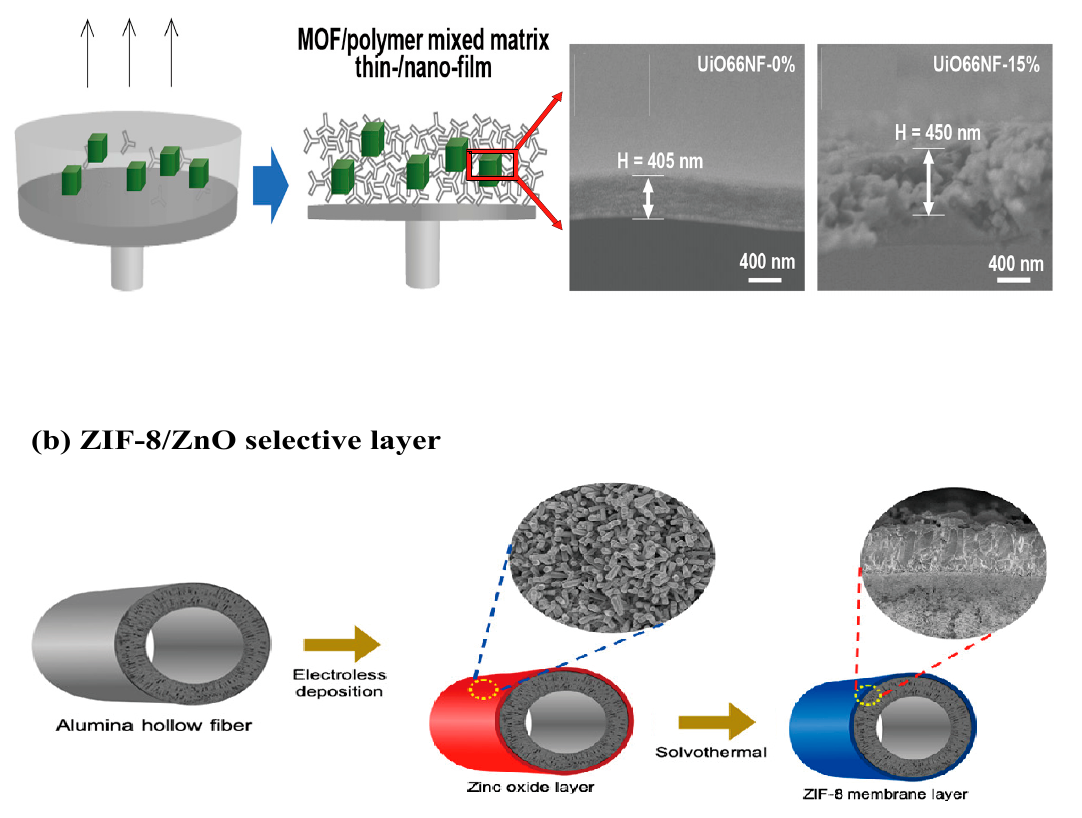
Figure 10. Review of the novel non-polyamide selective layer. ( a ) Freestanding of UiO-66/epoxy FO membrane; ( b ) ZIF-8/ZnO selective layer. All figures were taken from the references [155,156] .